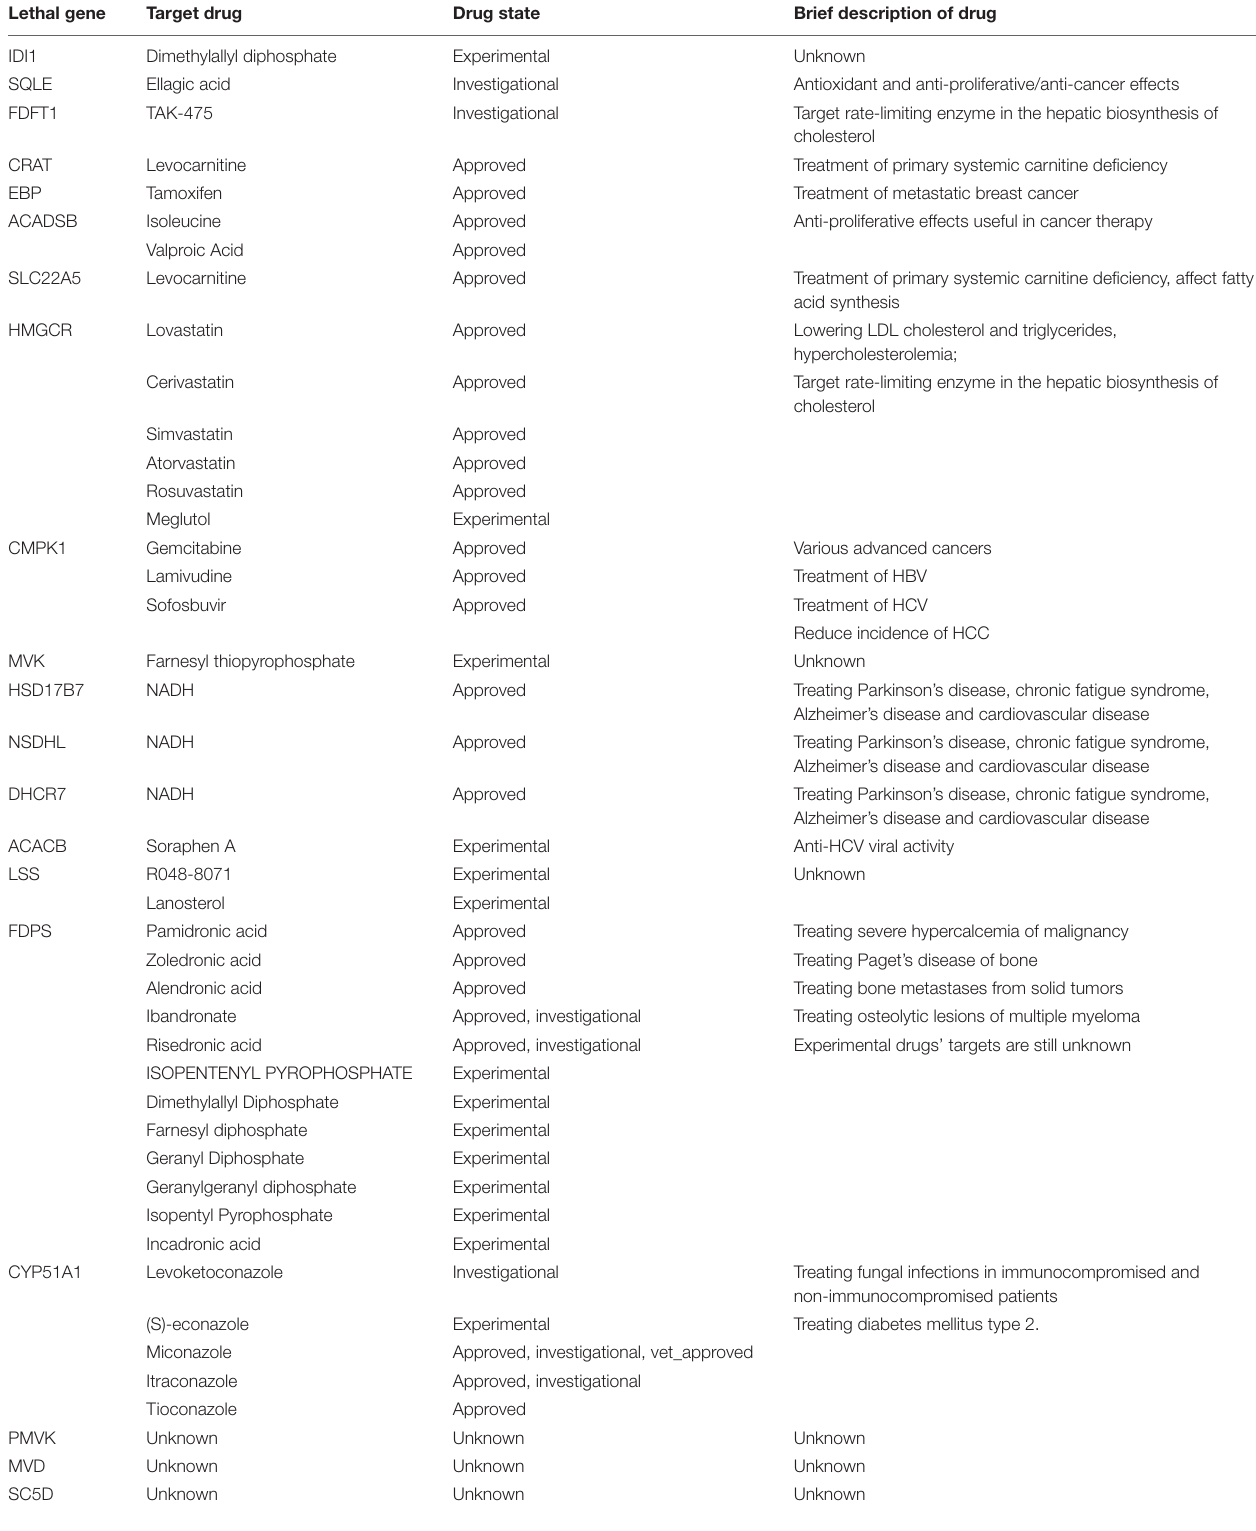
TABLE 2 | Lethal metabolic genes as potential targets and corresponding drugs in DrugBank. Lethal